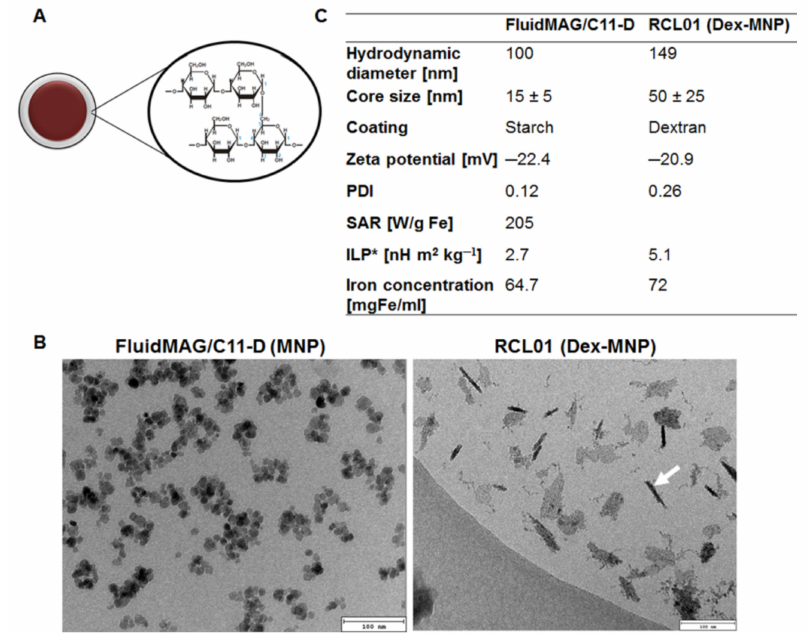
Figure 1. Characterization of magnetic nanoparticles. ( A ) Schematic presentation of the FluidMAG/C11-D particle core composed of Magnetite-C11 and starch coating. ( B ) Transmission electron micrographs of the nanoparticles revealing the particle core of approximately 15 and 50 nm diameter for the FluidMAG/C11-D and RCL01 (Dex-MNP), respectively. The white arrow points at a Dex-MNP lying perpendicular to the plane. Scale bars 100 nm. ( C ) Characteristic properties of the nanoparticles depicting hydrodynamic diameter, zeta potential, and polydispersity indices (PDI) deduced by dynamic light scattering; the iron concentration deduced by atomic absorption spectroscopy (AAS); and the specific absorption rate (SAR) and intrinsic loss power (ILP) determined with an AC frequency f = 1.048 MHz and field amplitude H o = 8.49 kA/m for the